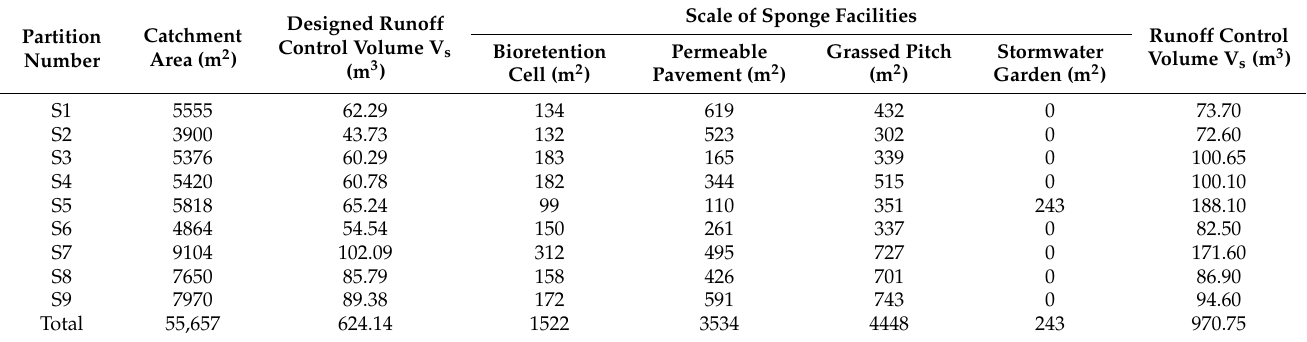
Table 2. Calculated runoff control volumes in each catchment